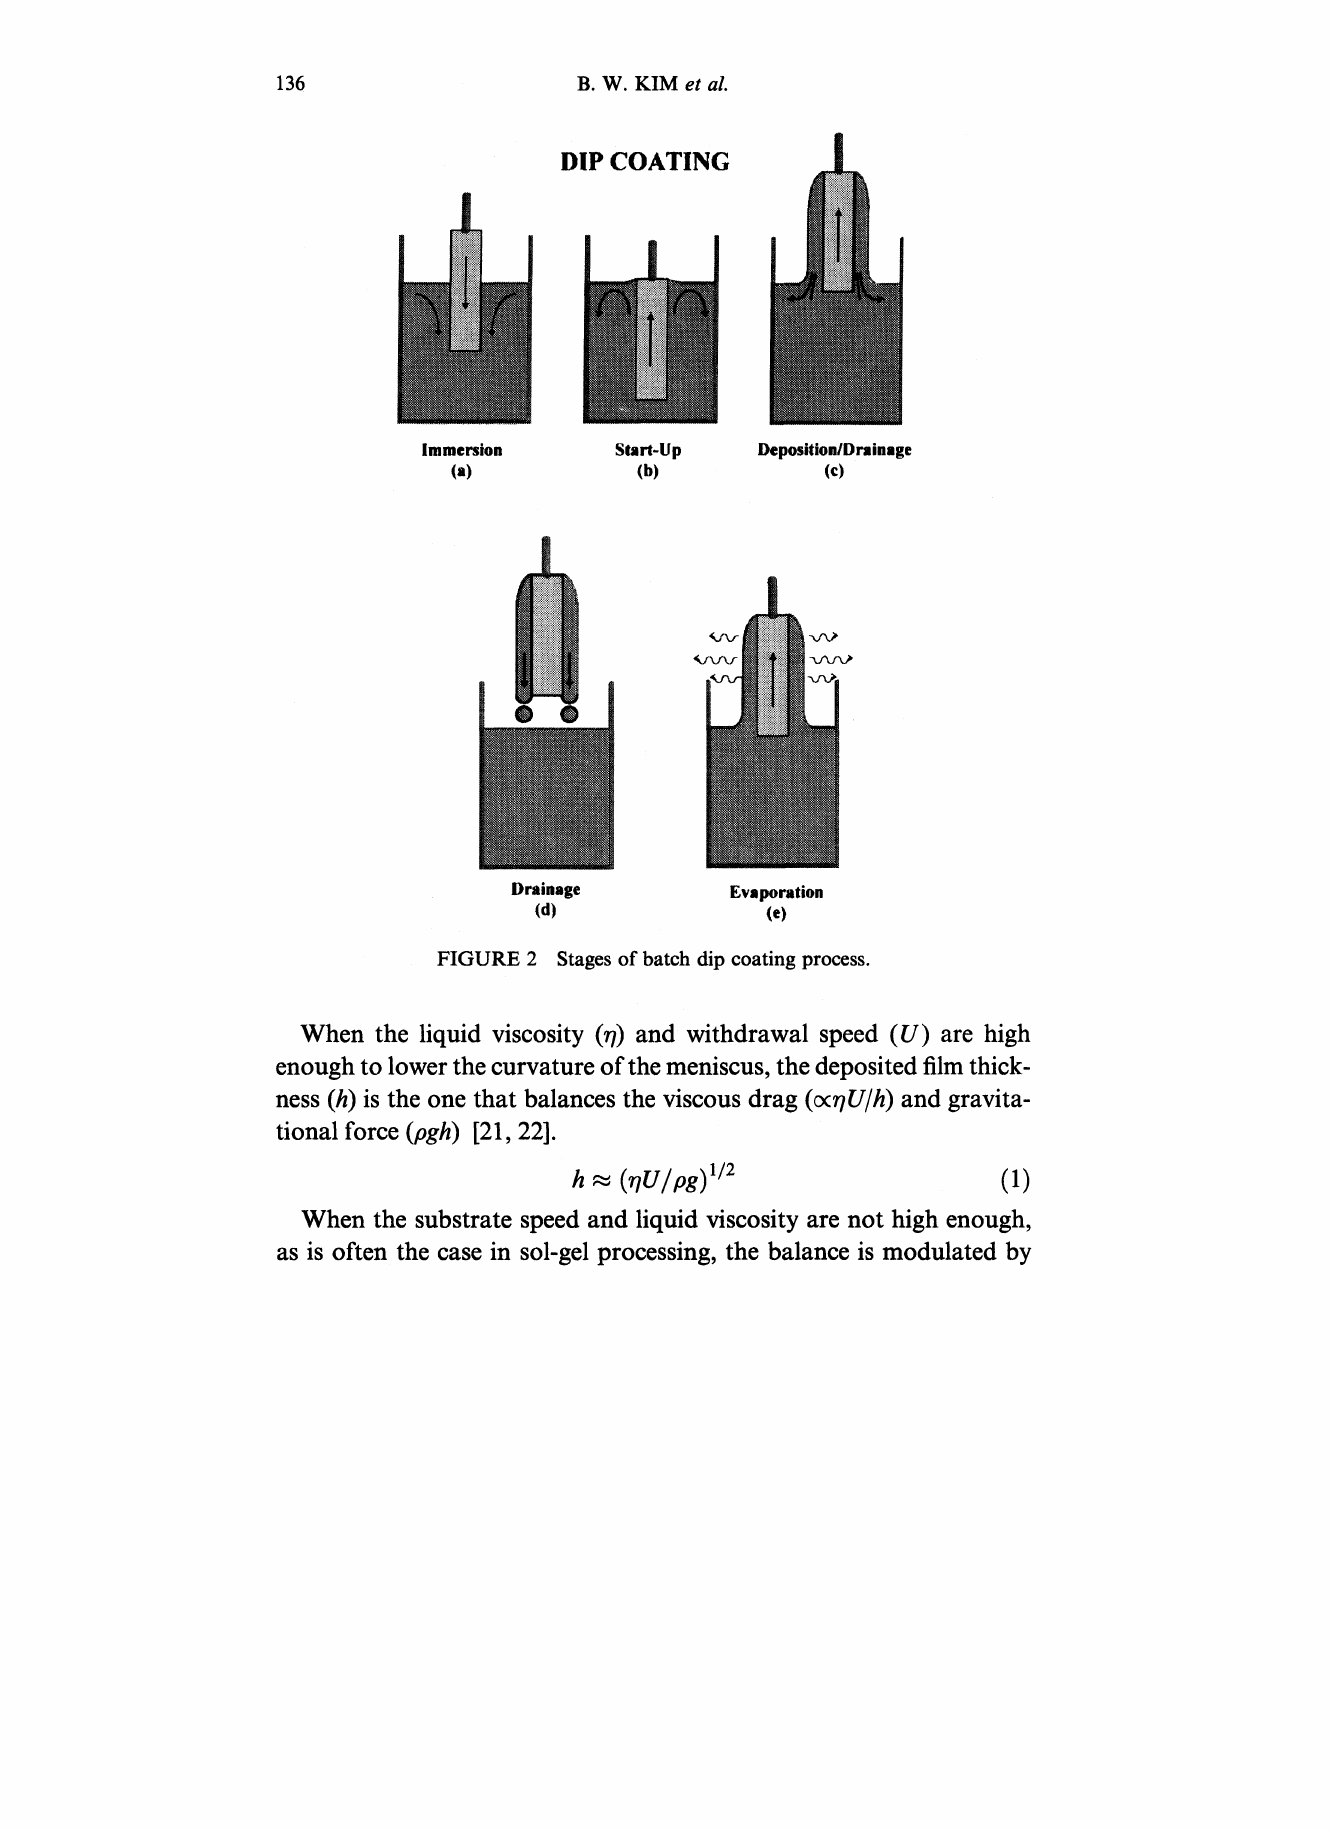
FIGURE 2 Stages of batch dip coating